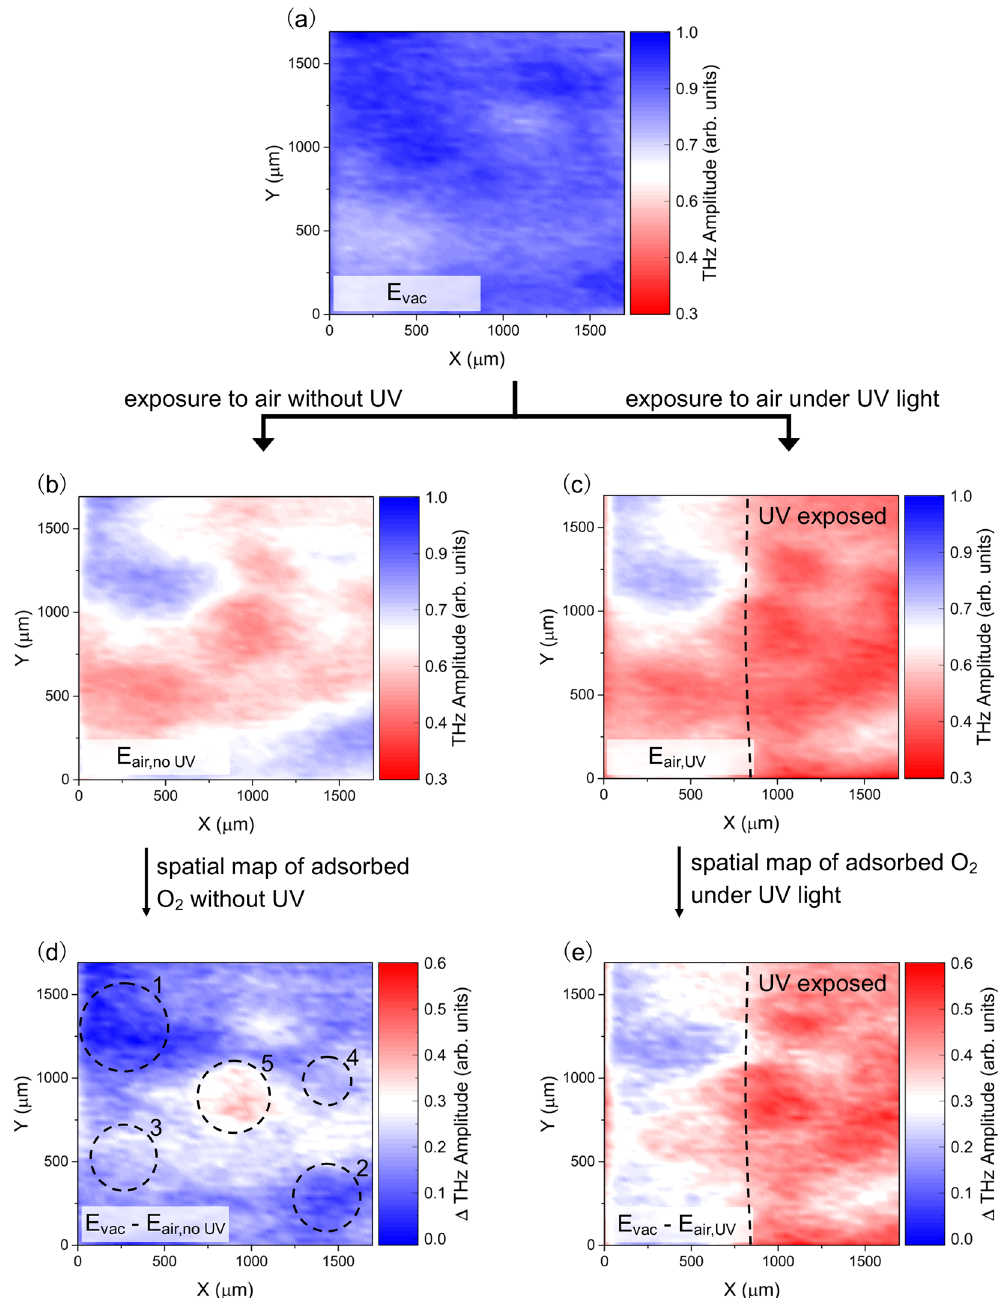
Figure 5. THz amplitude mapping during the O 2 adsorption process. ( a ) THz amplitude mapping for CVD graphene/InP after annealing at 445 K in vacuum. THz mapping of the same area in sample after exposure to air for a few minutes ( b ) without and ( c ) with UV illumination. The difference in THz mapping images before and after exposure to air gives a visualization of adsorbed O 2 molecules in the graphene surface. ( d ) Spatial map of adsorbed O 2 molecules in graphene after exposure to air without UV illumination which reveals regions with different “natural” affinities to O 2 molecules. Regions 1 and 2 (5) show the least (highest) amount of adsorbates after exposure to air, whereas regions 3 and 4 are areas with a fair amount of adsorbates. ( e ) Spatial map of adsorbed O 2 molecules after exposure to air under UV illumination, showing significantly higher concentration of O 2 adsorbates in the UV exposed part. In the THz amplitude maps ( a – c ), the blue (red) end of the scale signifies less (more) O 2 molecules on the graphene surface, while in the Δ THz amplitude maps ( d and e ), the blue (red) end of the scale signifies less (more) O 2 molecules adsorbed/added on graphene during exposure to